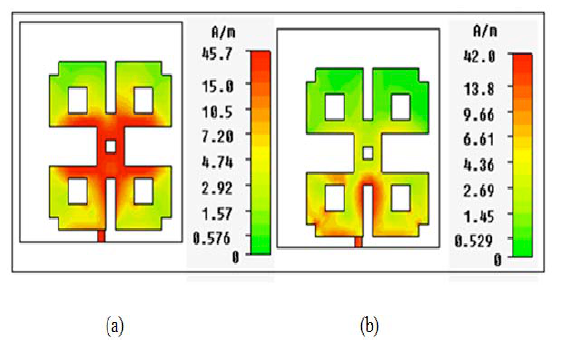
Figure 4: Current intensity distributions at (a) 3.5 GHz and (b) 7.8 GHz